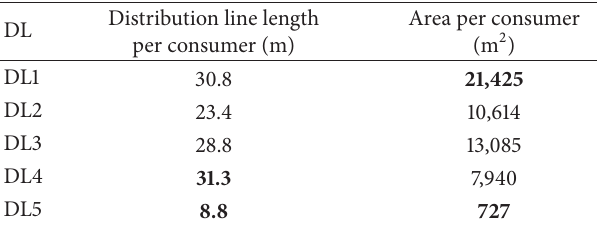
Table 1: Dispersion of consumers in each